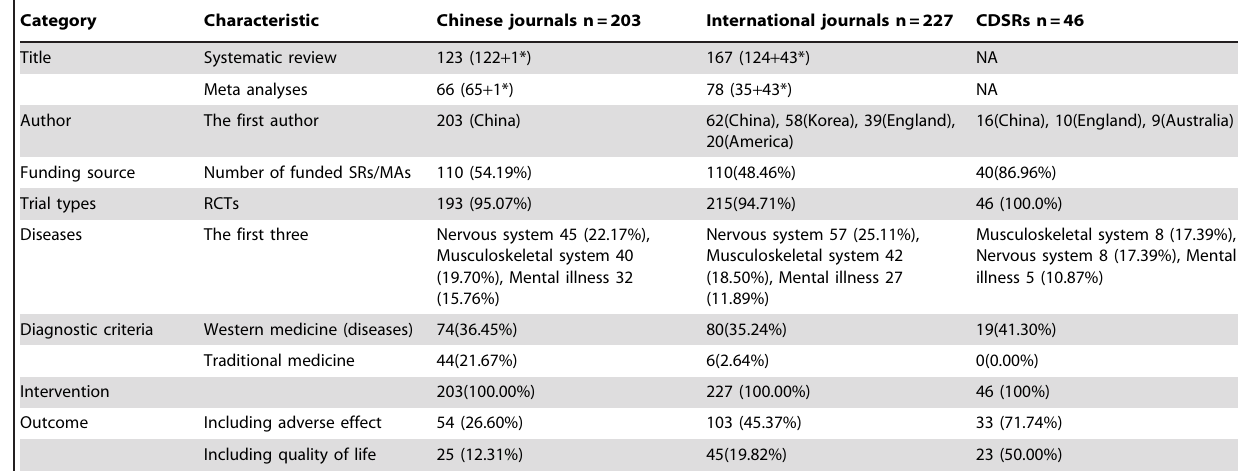
Table 1. Characteristics of included